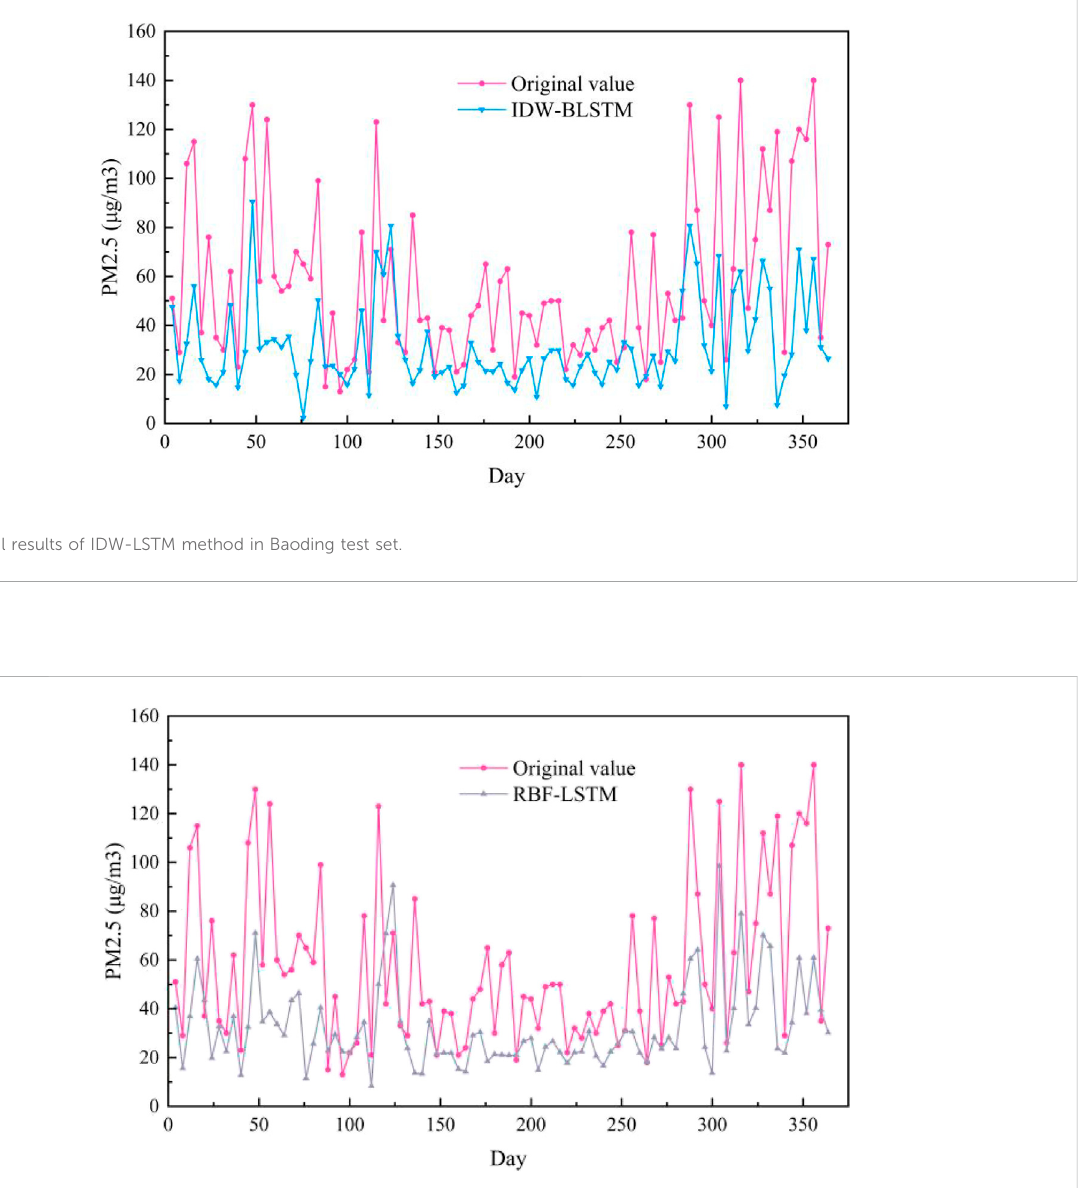
FIGURE 12 Experimental results of RBF-LSTM method in Baoding test